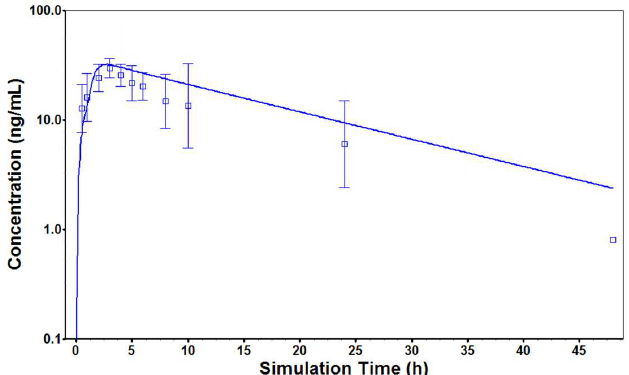
Figure 9. The predicted plasma profile of Matr in a 60 year-old American male generated based on our PBPK model (Figure 8C) was compared to the observed plasma profiles of n = 9